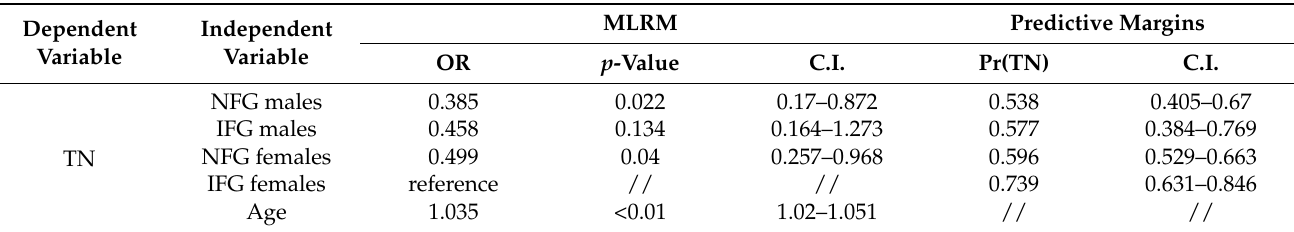
Table 4. Multivariable logistic regression model (MLRM) with TN as the dependent variable. Age and the four interaction categories according to sex and FPG status are the independent variables. IFG females were used as the base reference. Predicted probabilities of having TN (Pr(TN)) were calculated for each interaction category.